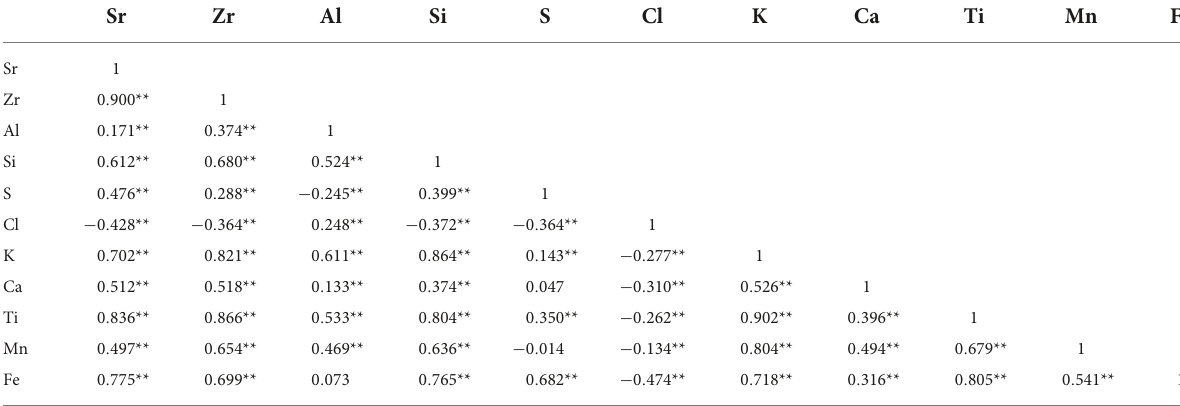
TABLE 2 Correlation coefficients between elements in the GC